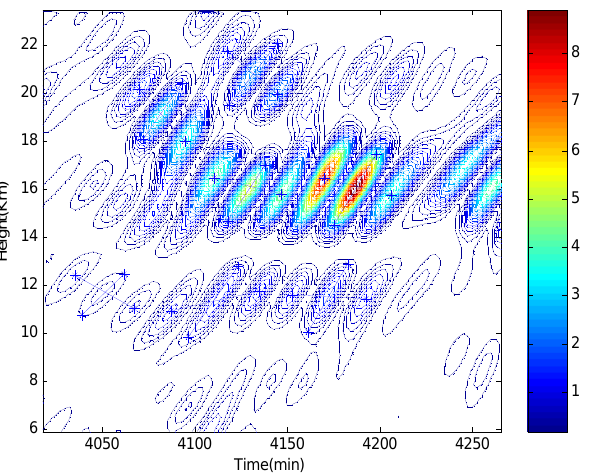
Fig. A3. The range time plot of (δV ) 2 converted from right panel Fig.A3 The range time plot of ( ) 2 V δ converted from right panel of Fig.A1 by the of Fig. A1 by the method of phase- and group-velocity tracing. Six method of phase- and group velocity tracing. Six wave packets were identified wave packets were identified and measured from this and measured from this map.